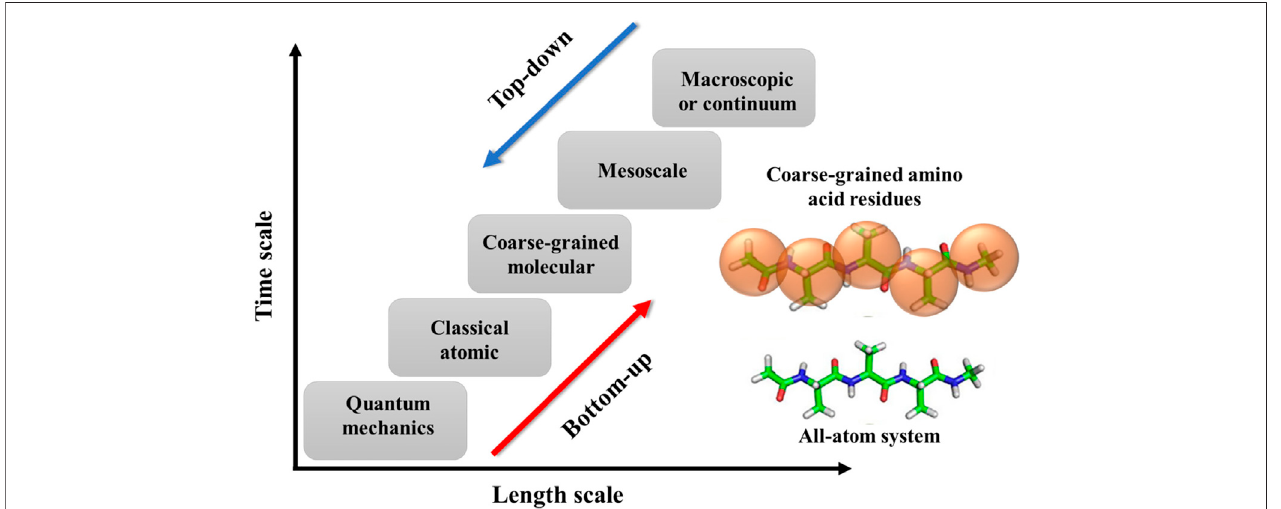
FIGURE 2 | Schematic diagram to show different spatial and temporal scales in the MD simulations of polymers as well as two types of coarse-grained methods: bottom-up and top-down. An example of the coarse-graining process of a polypeptide (polyalanine) is shown in the inset. Figure was reproduced from Ref. (Ye et al., 2021) with